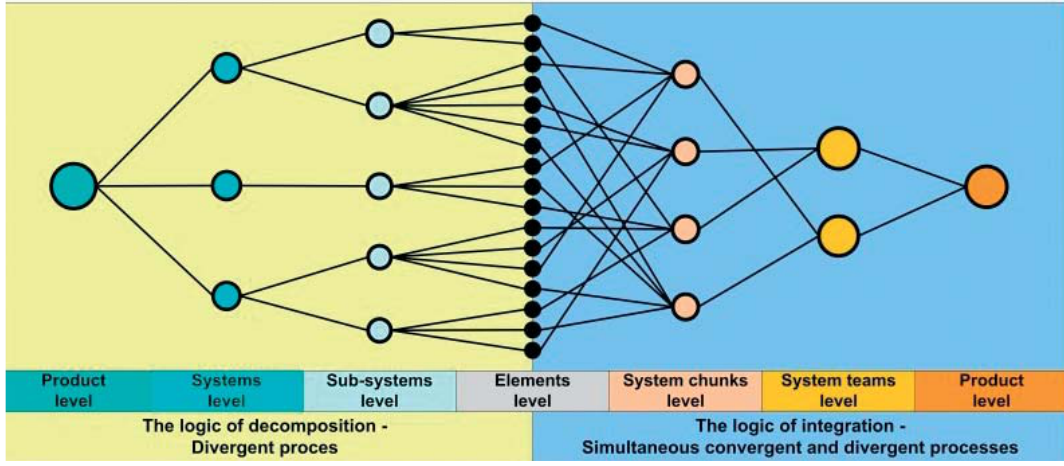
Figure 1: Managing Complexity - The Processes of Decomposition and